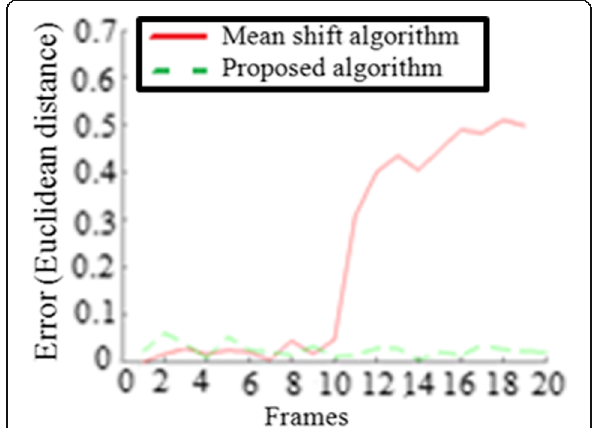
Fig. 23 Error graph of vehicle tracking to compare proposed algorithm with mean-shift algorithm